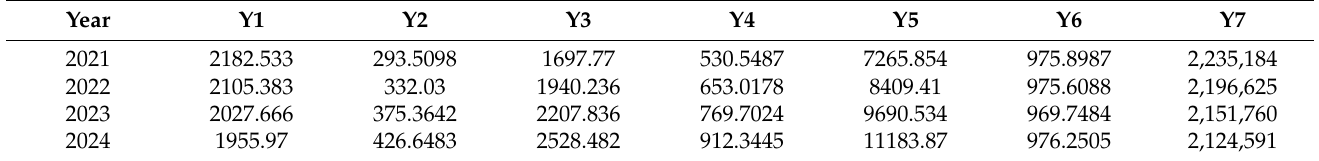
Table 9. Y-variable forecast values obtained on the basis of selected models.